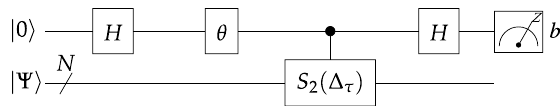
|ˆ S 2 ((cid:3) τ ) | (cid:6) (cid:3) or |ˆ S 2 ((cid:3) τ ) | (cid:6) (cid:3) if θ =